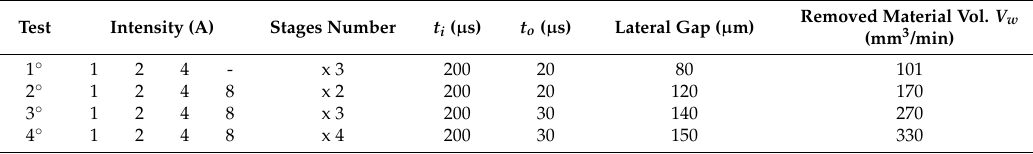
Table 4. Roughing parameters for the MoCuSi